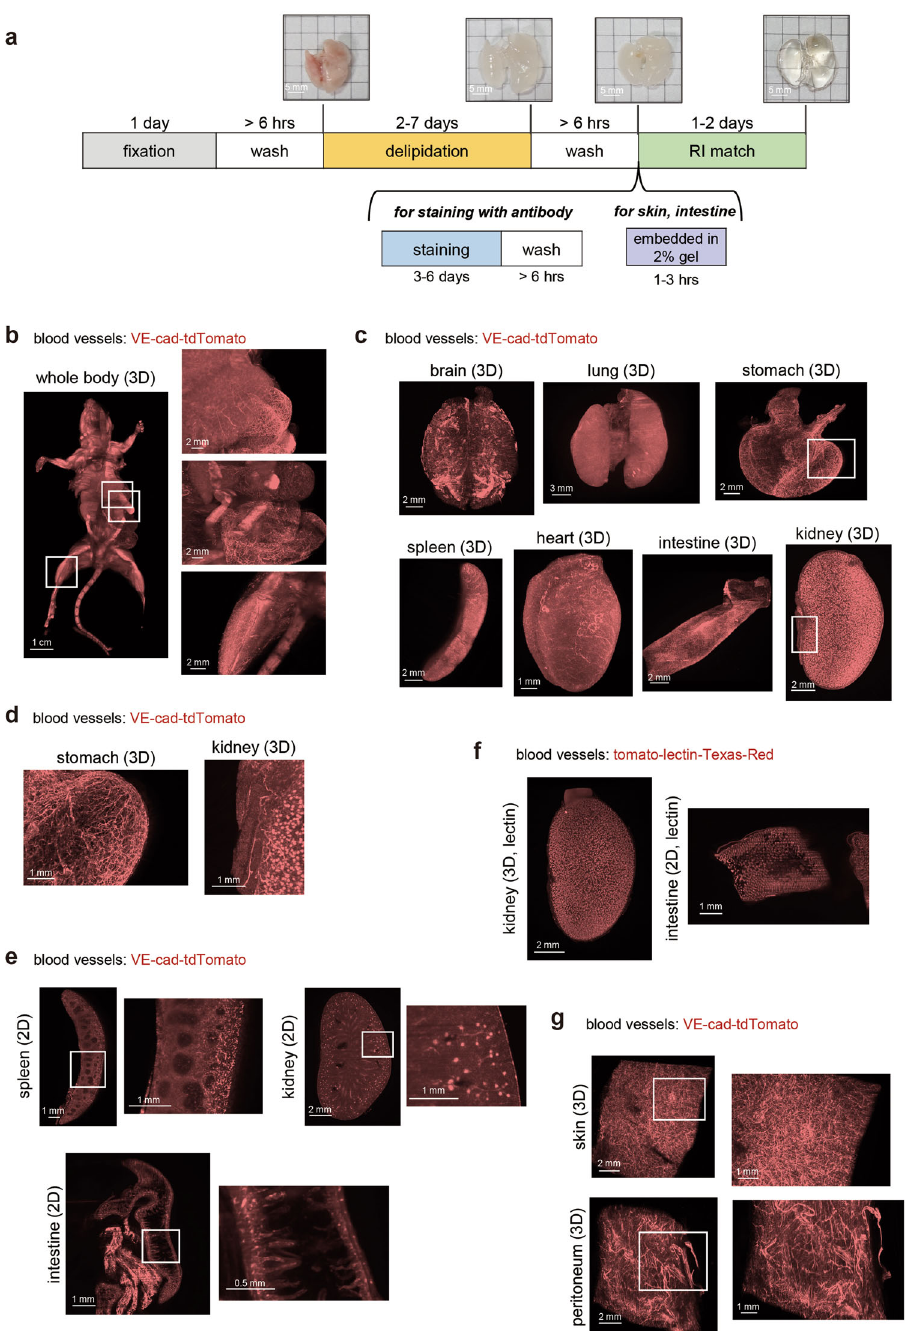
Fig. 1 | Whole-body and whole-organ 3D imaging of mouse blood vessels. a Whole-body/organ tissue-clearing protocol with CUBIC reagents. Mice were sacri fi ced and perfused with 4% PFA. The fi xed samples were subjected to CUBIC procedures.Thebasicprotocolconsistsof fi xation,delipidationwithCUBIC-L,and RI adjustment with CUBIC-R (N). For 3D immunostaining, staining with washing is inserted before RI adjustment. Samples from the skin and peritoneum were embedded into 2% gelatin before RI adjustment. The images of the transparent samplesarecapturedusinglightsheet fl uorescentmicroscopy(LSFM).Theimages ofthelungineachstepareshown. b The3D-reconstituted(3D)bodyimageofaVE- cad-tdTomato mouse (female, 4 months). Before CUBIC procedures, tamoxifen (Tx) was injected (i.p.) for the induction of reporter. The enlarged images of the abdominal organs (liver, stomach, intestine and leg) are shown in the right panels.